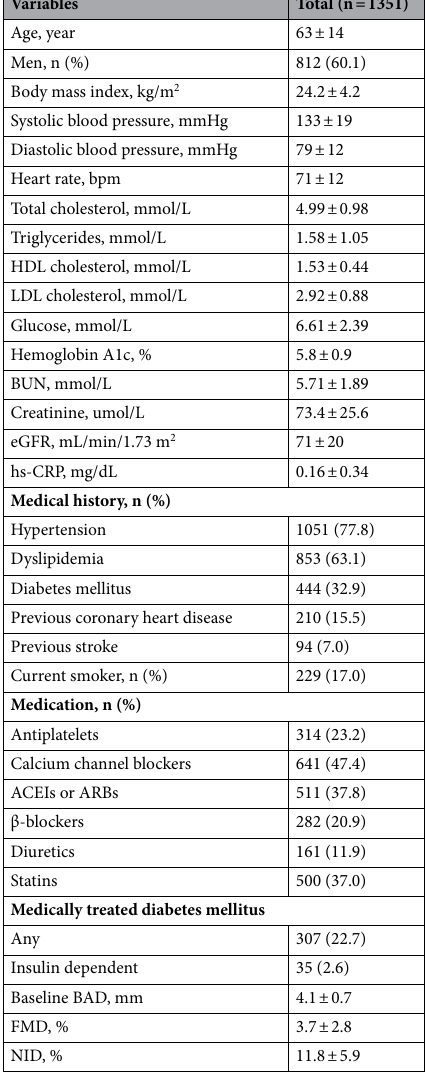
Table 1. Clinical characteristics of the subjects. Results are presented as means ± SD for continuous variables and percentages for categorical variables. HDL high-density lipoprotein, LDL low-density lipoprotein, BUN blood urea nitrogen, eGFR estimated-glomerular filtration rate, hs-CRP high-sensitive C-reactive protein, ACEIs angiotensin-converting enzyme inhibitors, ARBs angiotensin II receptor blockers, BAD brachial artery diameter, FMD flow-mediated vasodilation, NID nitroglycerine-induced